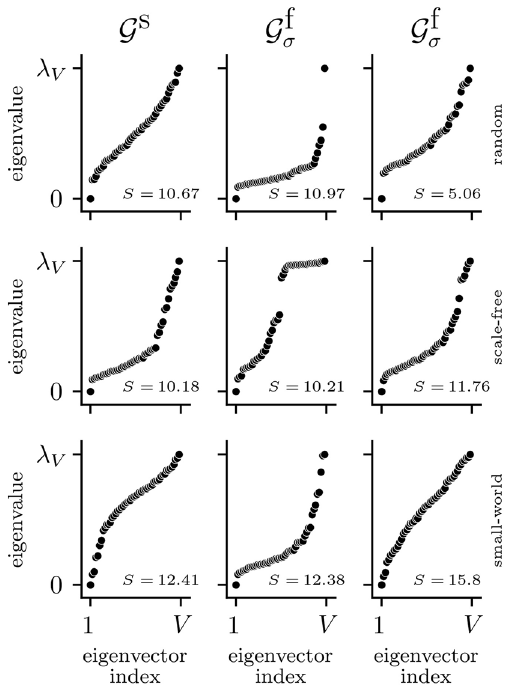
Figure 4. Exemplary eigenvalue spectra of Laplacian matrices of structural networks ( G s ; left column) and of corresponding functional networks ( G f σ ; middle and right columns). Middle column: G s and G f σ have comparable synchronizability S (relative difference between eigenratios � S < 5% ). Right column: G s and G f σ have comparable eigenvalue spectra (Pearson correlation coefficient > 0.98 ). Similar findings were achieved with mutual